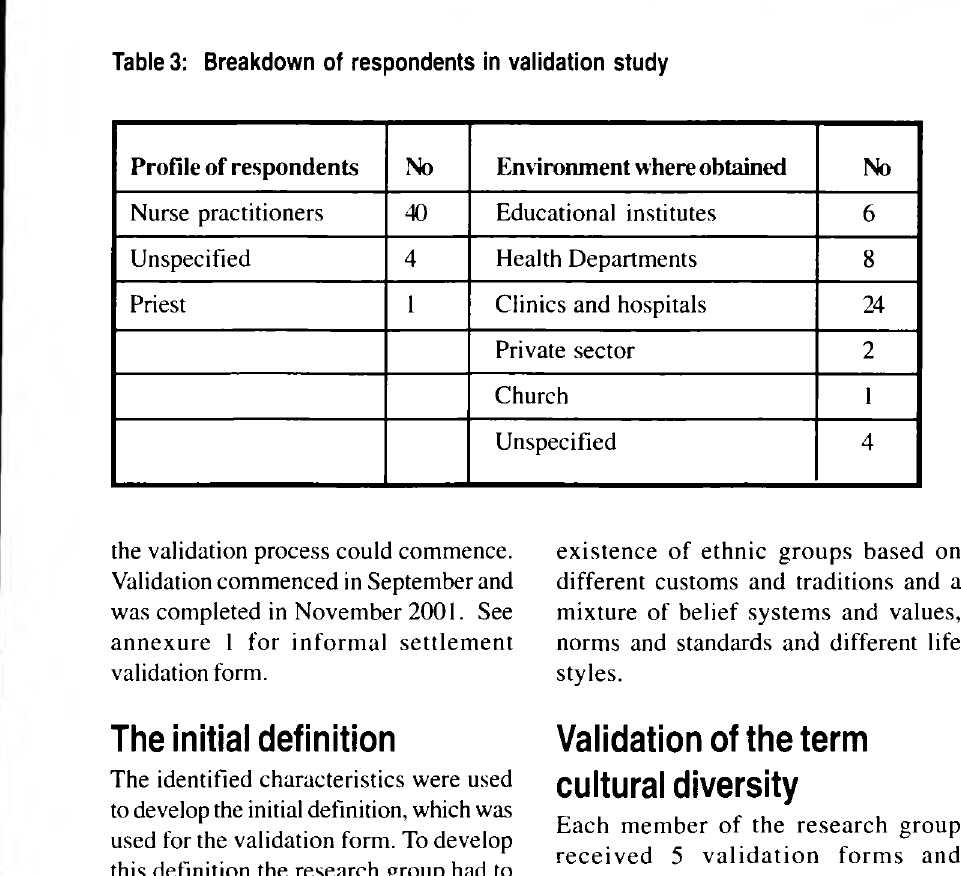
Profile of respondents